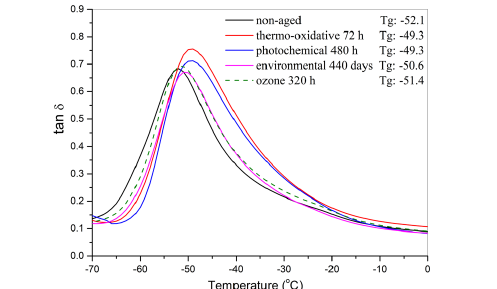
Figure 17. Aging effect on tan δ behavior as a function of temperature in compositions comprising 2.5 phr of 6PPD and 1.0 phr of TMQ (standard deviation in the temperature determination is ±0.5